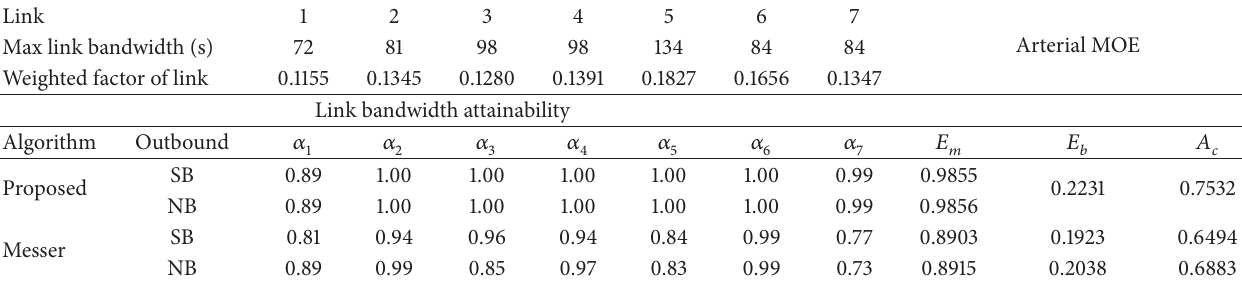
Table 10: Attainability of link bandwidth on Kietzke Lane with two algorithms.